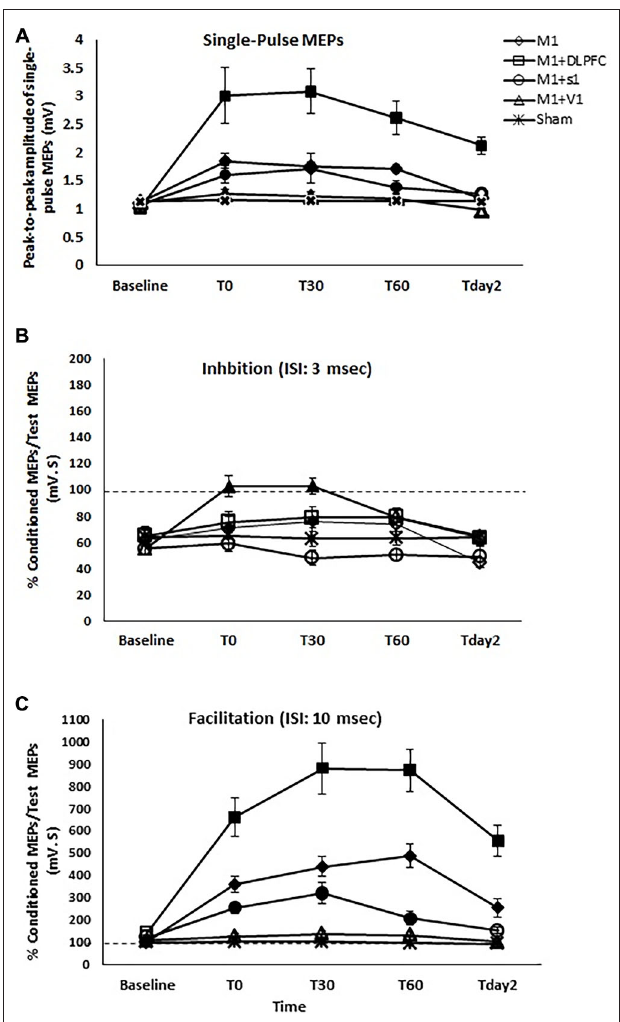
FIGURE 3 | The effects of different stimulation sites on the peak-to-peak amplitude of MEPs (A), SICI with ISI of 3 ms (B), and intracortical facilitation (ICF) (C) following a-tDCS of primary motor cortex (M1), a-tDCS UHCDS of M1 and DLPFC, M1and primary sensory cortex (S1), M1and primary visual cortex (V1), and sham. Filled symbols indicate significant deviation of the post-intervention MEP amplitude, SICI, and ICF compared to the baseline. Data are reported as mean ±